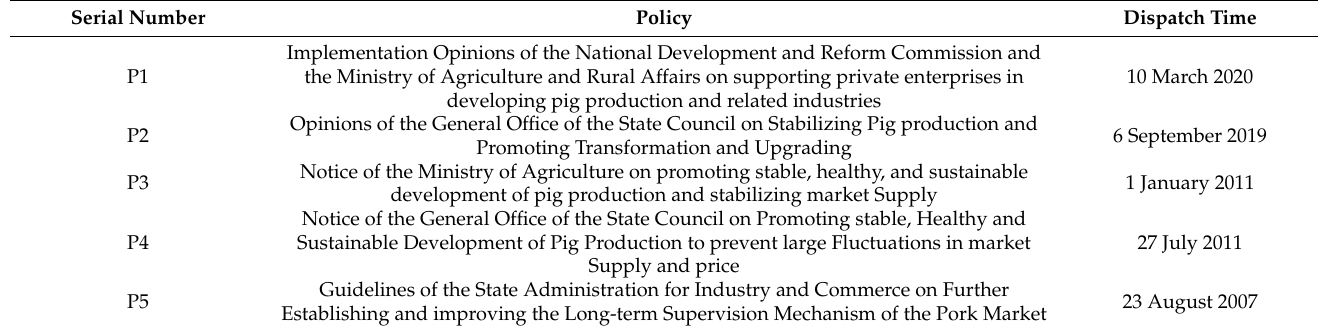
Table 6. Summary table of pig price control